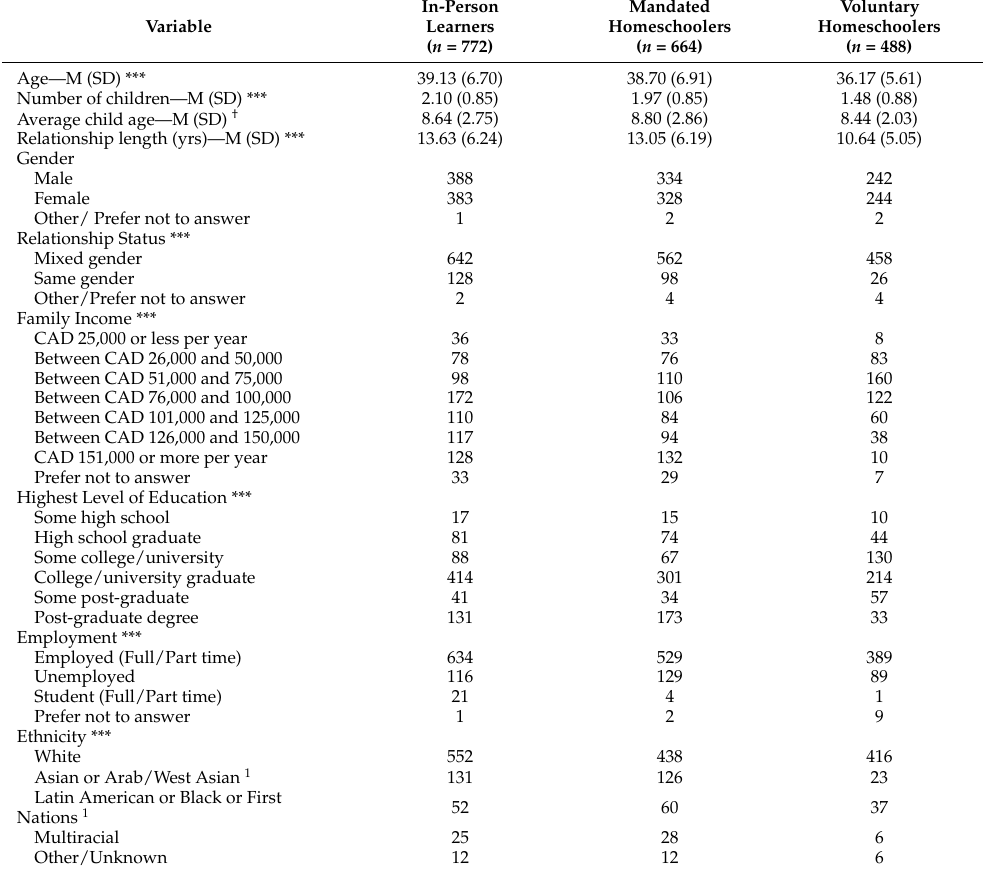
Table 1. Demographics information and relationship characteristics for the study